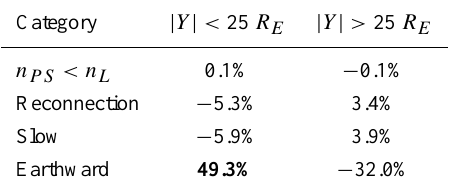
Table 3. Relative differences from expected values with respect